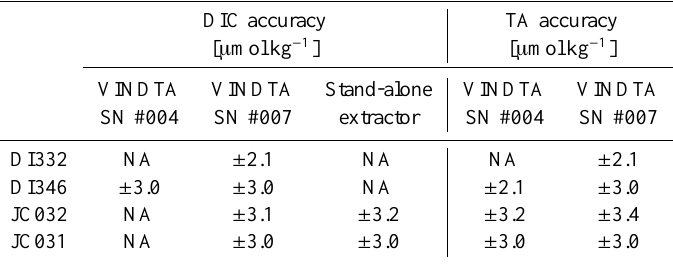
Table 5. Accuracy of DIC and TA measurements for each instrument and section. The accuracy is defined as the standard deviation of CRM values around the mean, after first-level QC and second-level QC using the CARINA dataset. A second-level QC with new data in GLODAP 2 recommends to lower TA during JC031 by 10 µ molkg − 1 (R. Key, personal communication,